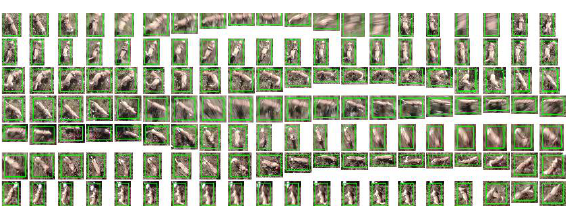
Figure 8. Examples of dog tracking results. We dissect the tracking results into seven components (0–6), illustrating the inner working mechanism of the tracking algorithm we used. Overall we observed that the tracking algorithm worked well on the videos we collected. We show the tracking bounding boxes every five frames. The bounding boxes in red represent either the initialized box (e.g., in the first frame) or re-initialized boxes (e.g., after the tracking failed due to the dog being completely occluded for a while from (4,5)). The bounding boxes in green are from online tracking. It also is observed that the tracking drifts due to fast motion caused either by the drone moving or by the dog running, e.g., in (2). Best viewed in magnification for checking the cropped individual tracking